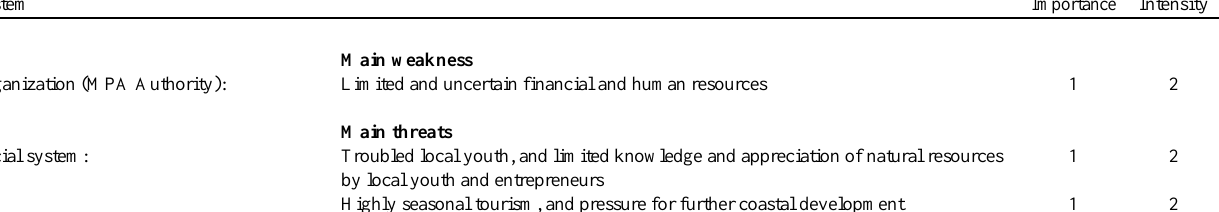
Table 3 . Main weaknesses, threats, strengths, and opportunities of the Tavolara-Punta Coda Cavallo Marine Protected Area (MPA). The importance of each weakness, threat, strength, and opportunity was scored as 0 = low importance or 1 = high importance; their intensity (or magnitude) was scored as 0 = low, 1 = medium, or 2 = high